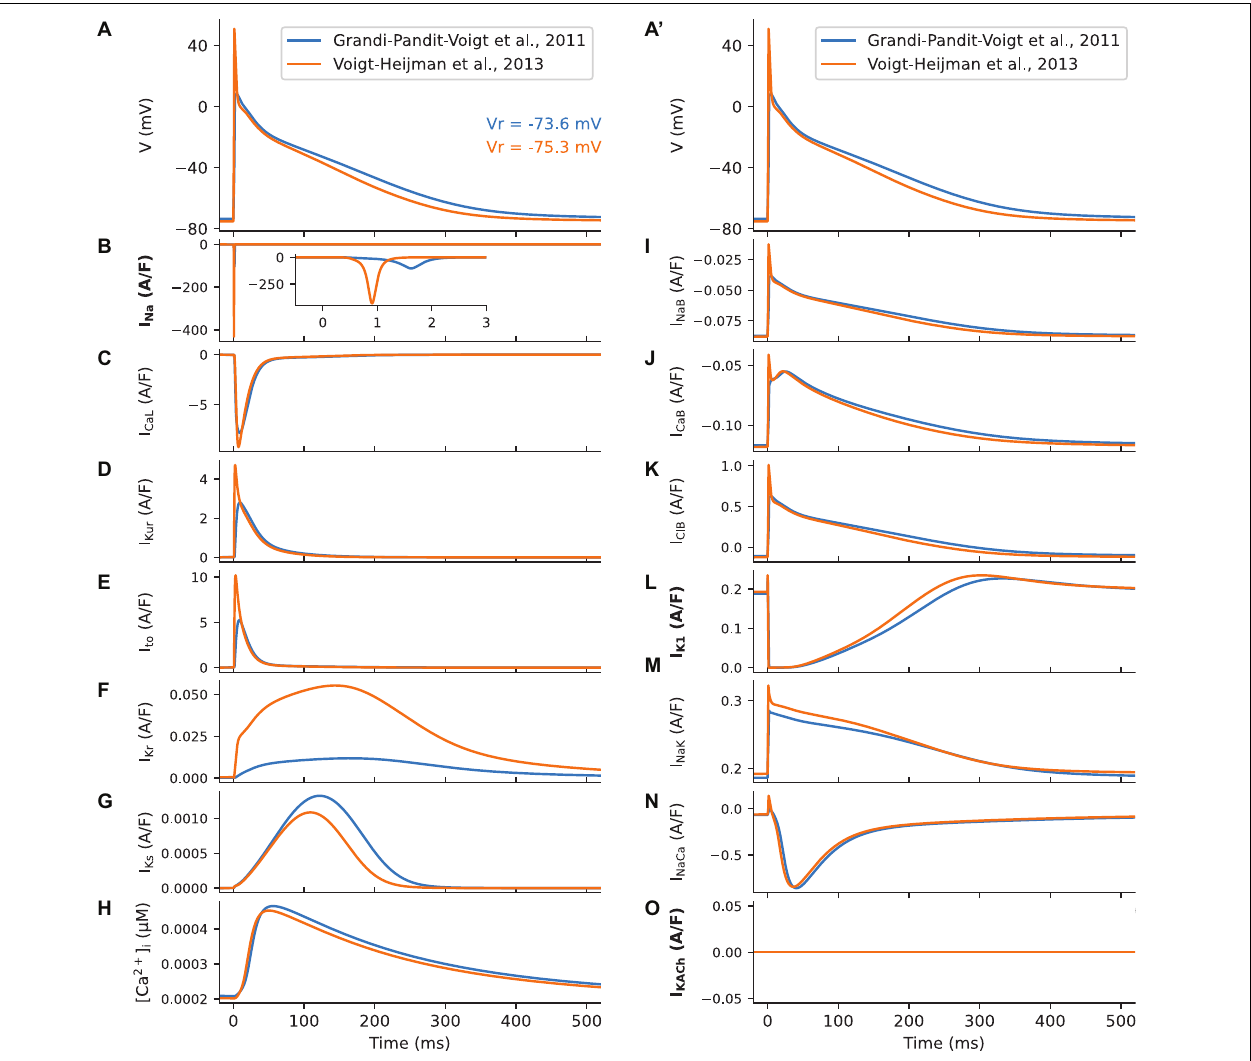
FIGURE 1 | Summary of the human atrial membrane action potential and underlying transmembrane ionic currents. The AP traces (A, A’) and underlying currents were computed using the original Grandi et al. (2011) model (blue) and the Voigt et al. (2013) modification. Where the underlying model formulation differs, labels for the respective transmembrane currents have been highlighted in bold. (B) Shows marked differences in the Na + currents that generate the AP upstroke, caused by the changed Na + current formulation. (C) shows L-type Ca 2 + currents; (D) illustrates the rapidly activating delayed rectifier K + current, I Kur ; and (E) denotes the Ca 2 + -independent transient outward current, I to . (F, G) show the fast and slow time- and voltage-dependent delayed rectifier K + currents, IK r (F) and I Ks (G) . (H) , illustrates model generated changes in intracellular [Ca 2 + ] i that take place during the AP. In both models there are three time-independent or background currents: the Na + current is shown in (I) ; the background Ca 2 + current in (J) and the background Cl − current in (K) . Data depicting the inwardly rectifying K + current, I K1 is shown in (L) . Although the equations for this current differ between models, only modest differences between the produced current traces are observed. The electrogenic current generated by the Na + /K + pump is shown in (M) . A second distinct electrogenic current produced by the Na + /Ca 2 + exchanger is illustrated in (N) . In the Voigt et al. (2013) model it is also possible to simulate one of the effects of acetylcholine by utilizing a second distinct background K + current, I KACh . In this study, we did not make use of this feature and thus this current was turned off as illustrated in (O) . Note that the two superimposed APs in (A, A’) are identical; this was done to more clearly illustrate the sizes and time courses of the underlying currents in each column relative to the AP